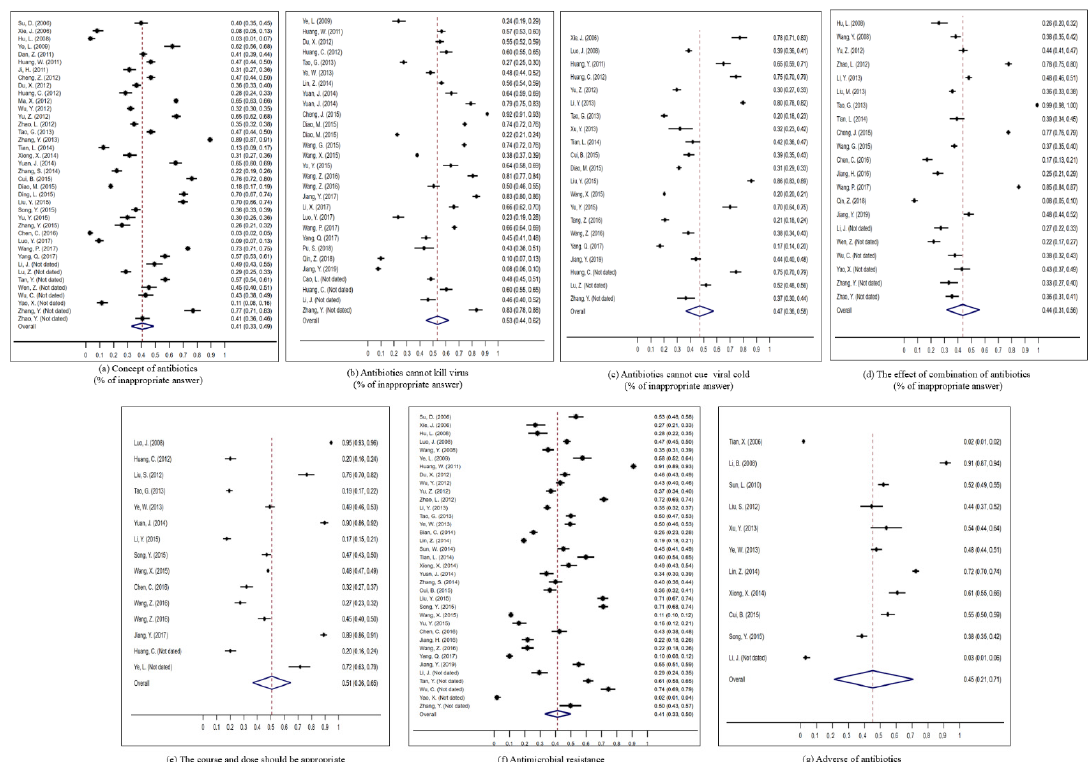
Figure 4. Meta–analysis of the pooled proportion of the general population’s misconceptions regarding antibiotic use. ( a ) Concept of antibiotics (% of inappropriate answer). ( b ) Antibiotics cannot kill virus (% of inappropriate answer). ( c ) Antibiotics cannot cue viral cold (% of inappropriate answer). ( d ) The effect of combination of antibiotics (% of inappropriate answer). ( e ) The course and dose should be appropriate (% of inappropriate answer). ( f ) Antimicrobial resistance (% of inappropriate answer). ( g ) Adverse of antibiotics (% of inappropriate answer).